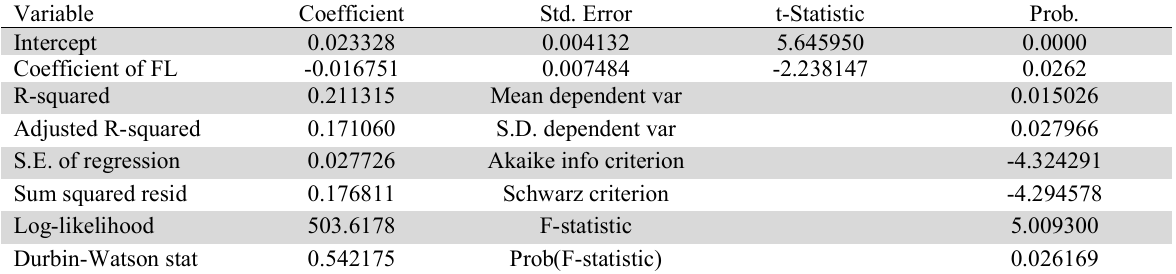
ROA model (Dependent variable: ROA, Observations: 357)